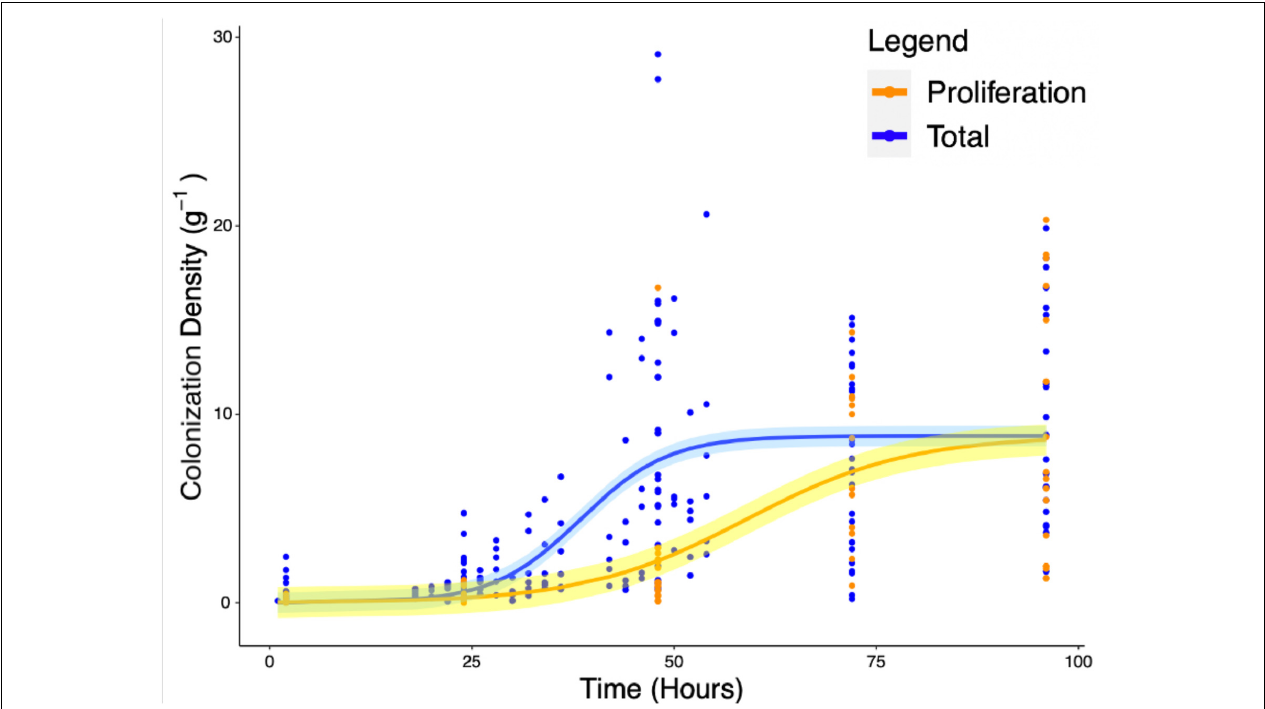
FIGURE 5 | Increase of total root surface colonization density (blue) as well as increase due to proliferation (orange) were modeled using the logistic equation. The accumulation of P. fluorescens SBW25 E1433 on root surfaces over time is shown with root surface colonization density represented by CFU normalized for original inoculant and root weight (Eq. 4). Each point represents a destructive measurement of CFU on the root surface of an individual plant. Lines represent fitted logistic models. The total values, shown in blue, represent the bacteria present on the root due to both attachment and proliferation (total colonization density). The proliferation values, shown in orange, represent bacteria proliferating on the root in the absence of attachment beyond 2 h. Shaded regions represent bootstrap errors.